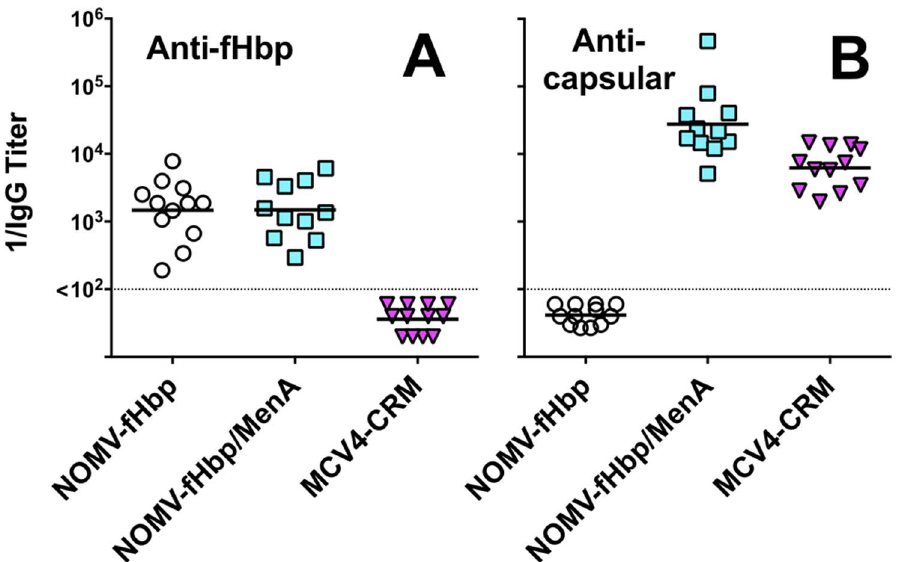
Figure 6. Serum IgG antibody responses to vaccination as measured by ELISA. Panel A. Anti-fHbp ID 9 titers. Panel B. Anticapsular antibody titers to MenA polysaccharide. Each symbol represents the reciprocal titer of an individual immunized mouse. Horizontal lines denote reciprocal geometric mean titers. There were no significant differences in the IgG anti-fHbp antibody titers elicited by the NOMV-fHbp or combination NOMV- fHbp/MenA conjugate vaccine (P . 0.5). The serum IgG anticapsular titers were higher in mice immunized with the combination NOMV-fHbp/Men A conjugate vaccine than the control MCV4-CRM conjugate vaccine (P=0.001).